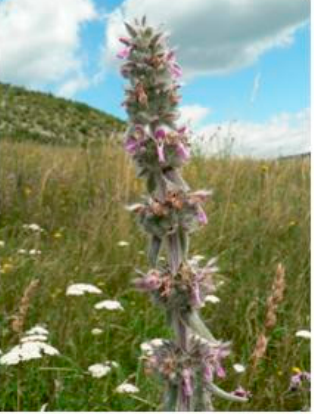
Figure 8. Stachys germanica L. (by courtesy of Saxifraga Foundation).